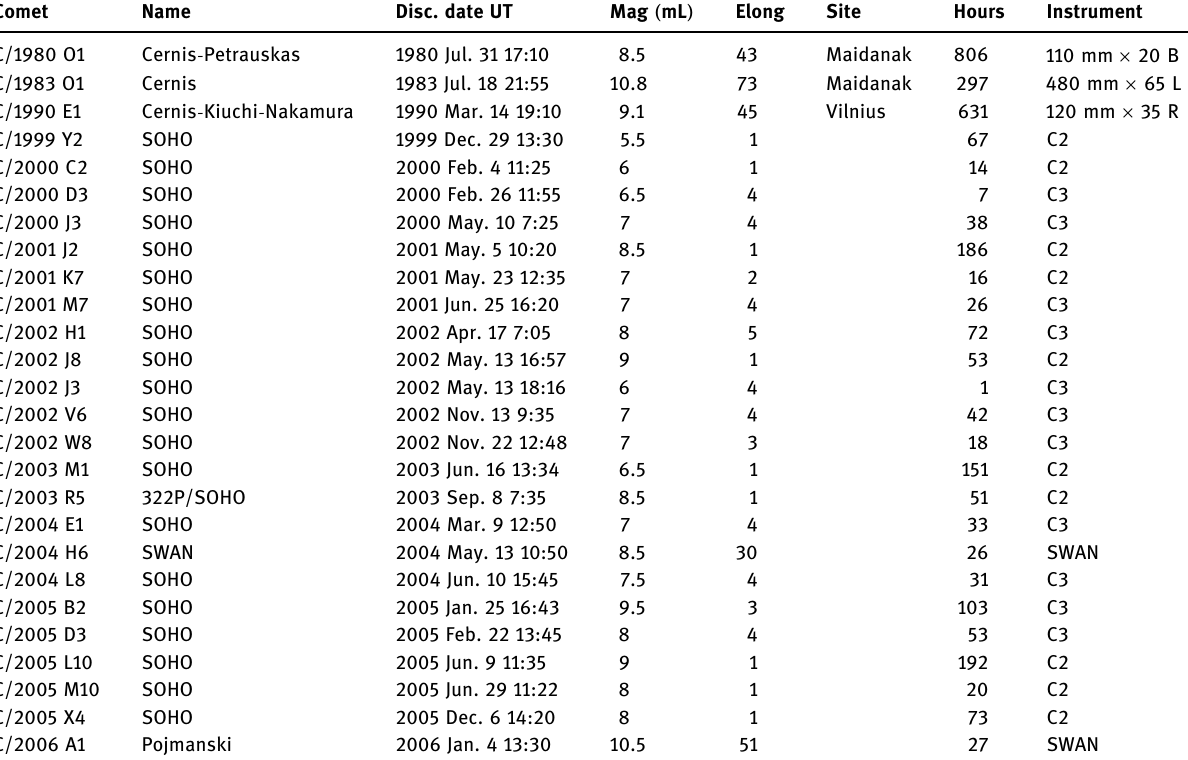
Table 2: Comets discovered by K.C.